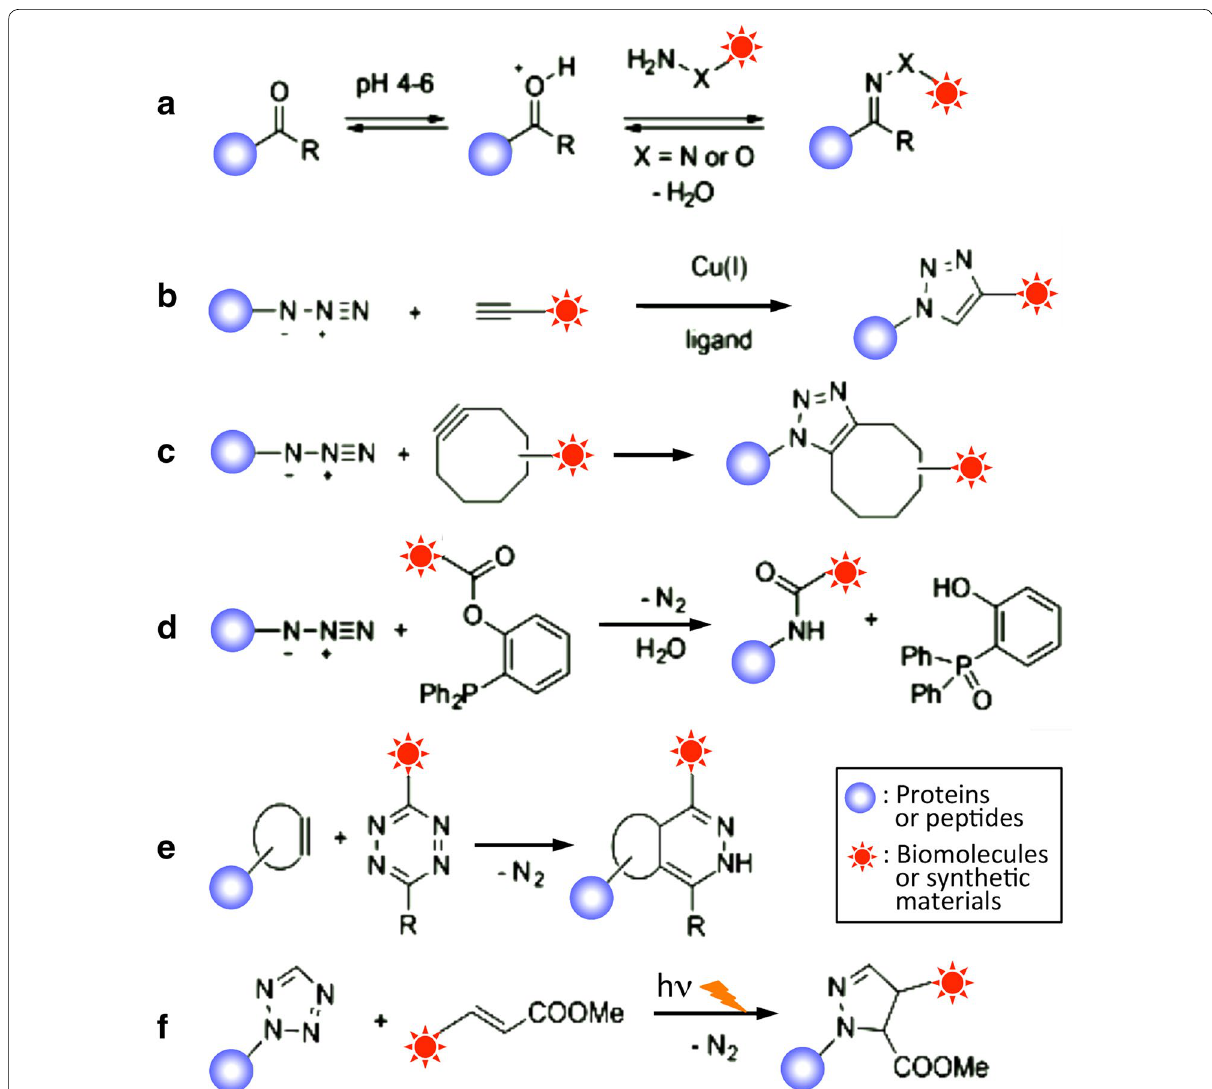
Fig. 20 Chemoselective bioconjugation reactions. a Ketone/hydroxylamine condensations. b Copper-catalyzed alkyne–azide Huisgen cycload- ditions. c Strain-promoted alkyne-azide cycloadditions. d Staudinger ligation. e Diels–Alder cycloadditions. f Photo-click cycloadditions (Figure adapted with permission from: Ref. [224]. Copyright (2014) American Chemical